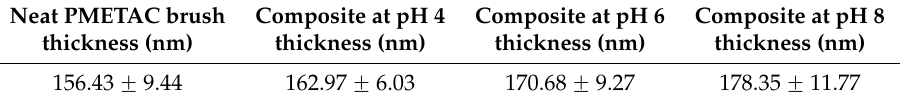
Measurements of the thickness in water of PMETAC/AuNP composites using the AFM full-indentation method. The thickness of the neat polymer brush was also listed for comparison reasons.